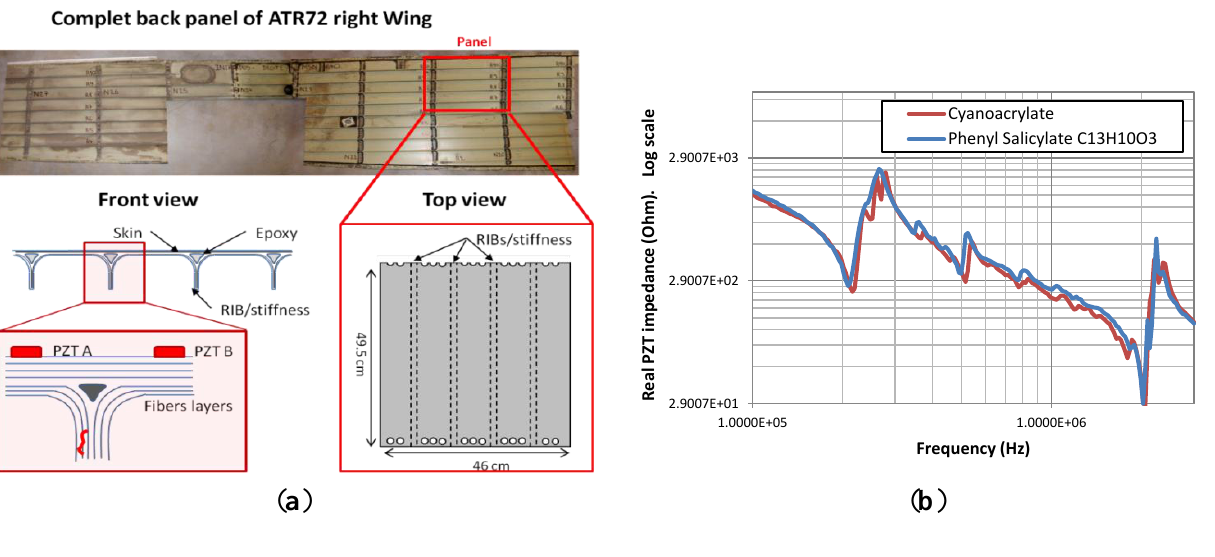
Figure 7. ( a ) Specimen of real aircraft structure part extracted from a right wing panel of an ATR72. ( b ) Influence of the pasting method on the PZT impedance response. The tests were done using cyanoacrylate glue and phenyl salicylate,